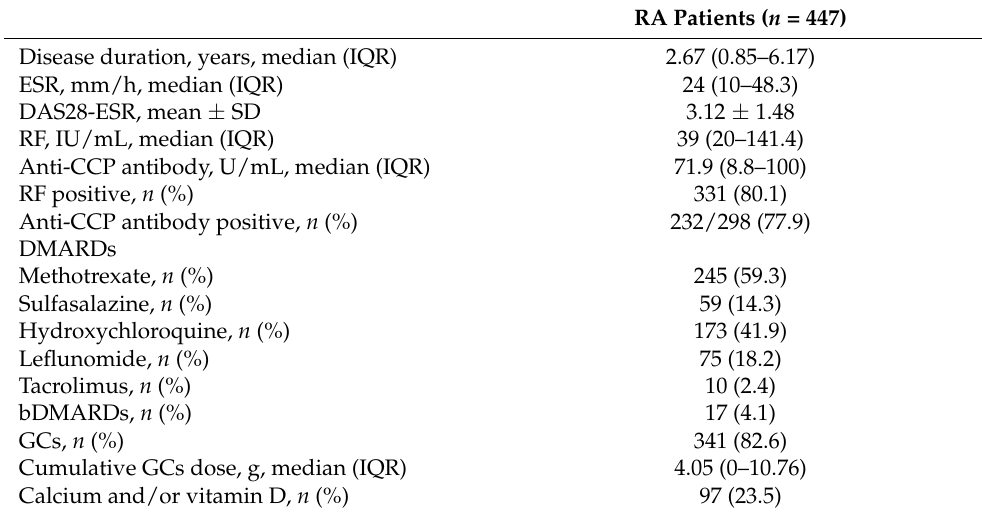
Table 2. Baseline disease characteristics in postmenopausal patients with rheumatoid arthritis.